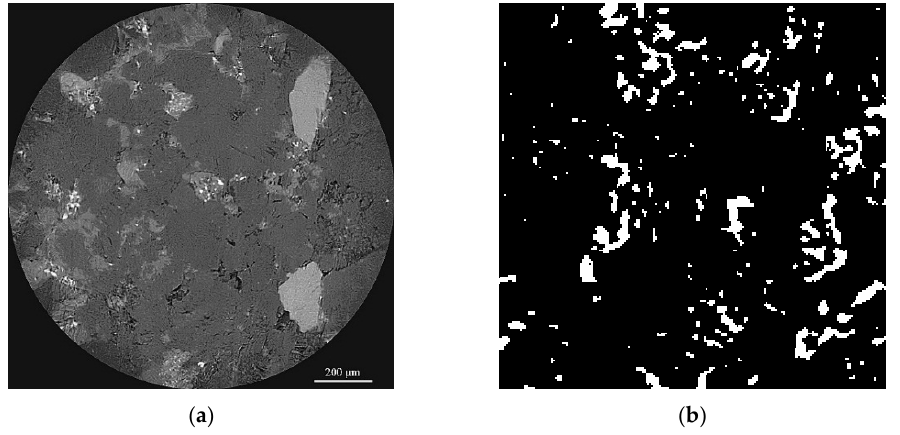
Figure 1. Y288-10 X-ray CT image: ( a ) Y288-10 original grayscale image; ( b ) Y288-10 binary image. By accumulating the binarized image slices and using the three-dimensional visuali- zation technology, the digital rock constructed by the X-ray CT method was obtained, as shown in Figure 2, in which blue is the skeleton and red is the pore.